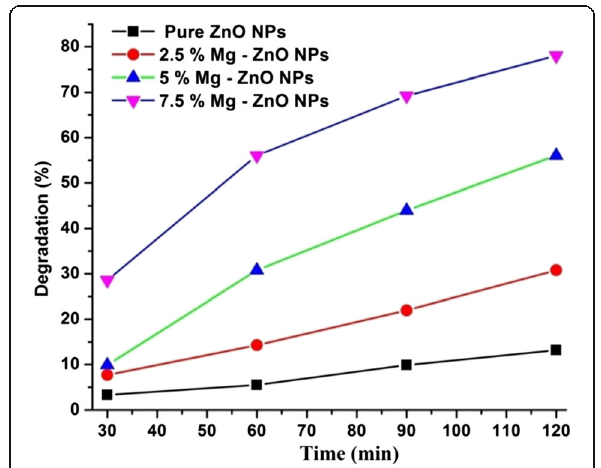
Fig. 8 Photodegradation of Rhodamine B under pure and IZ-NPs